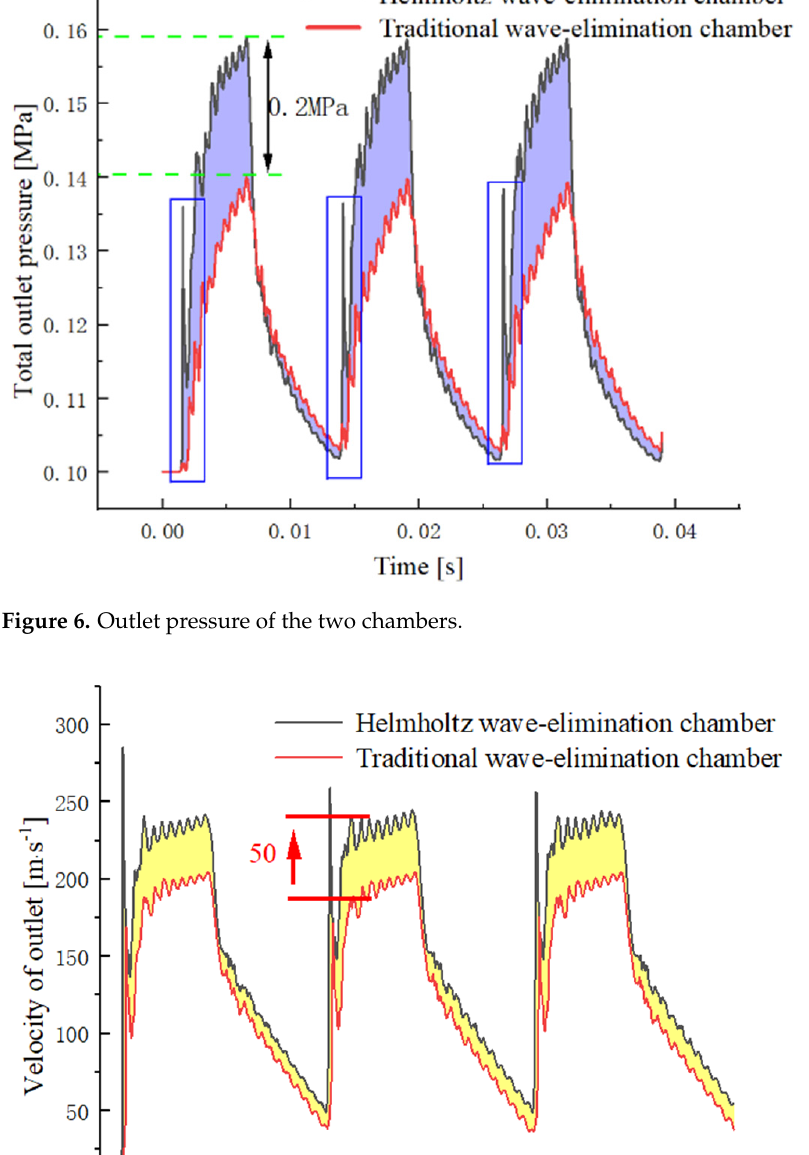
Figure 6. Outlet pressure of the two chambers.